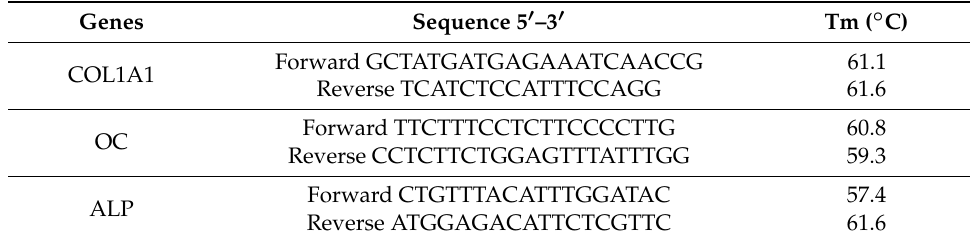
Table 2. Human primer sequences used for determination of relative gene expression levels by reverse transcription-polymerase chain reaction analysis.